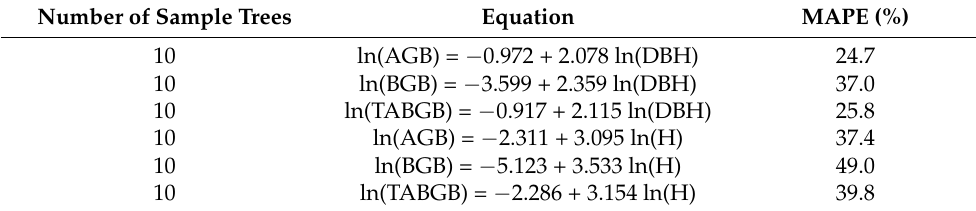
Table 6. The mean absolute percentage error of the validation. Number of Sample Trees